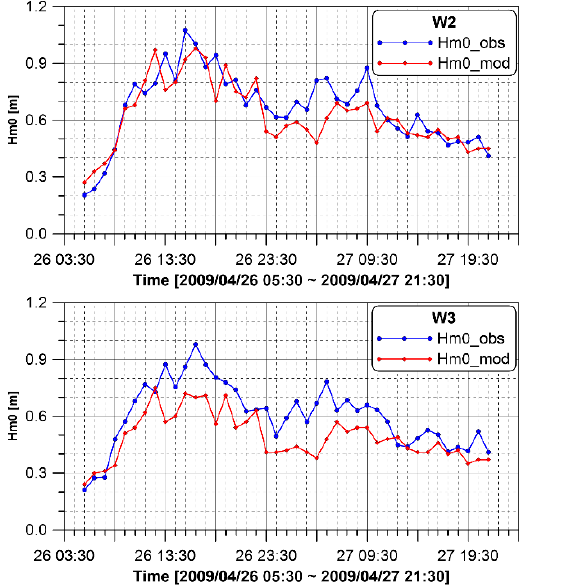
Figure 13. Comparison of wave height ( H m 0 ) between the observational (blue) and modeled (red) data at the four wave stations inside Pohang New Port (W2, W3, W4, and W5) during the period of the wave event selected for BC from 05:30 on the 26 to 21:30 on 27 April 2009. Reasonable agreements are observed between the observational and modeled data, supporting the model